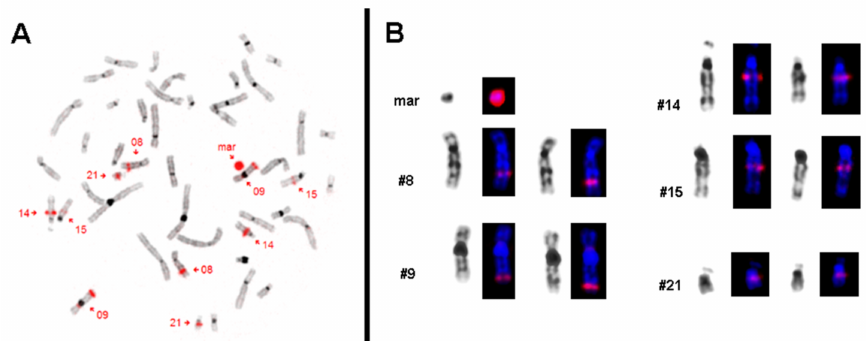
Figure 2. Results of reverse FISH analysis after microdissection of the sSMC. ( A ) The microdissection- derived probe is labeled in red and hybridized back on a metaphase of the patient. The sSMC (mar) is completely stained and the five chromosomes with corresponding signals are highlighted. ( B ) All chromosomes from a patient’s metaphase after hybridizing with microdissection-derived sSMC probe are shown in inverted DAPI (4 (cid:48) ,6-diamidino-2-phenylindole) banding as well as stained in DAPI (blue) with the red signals.